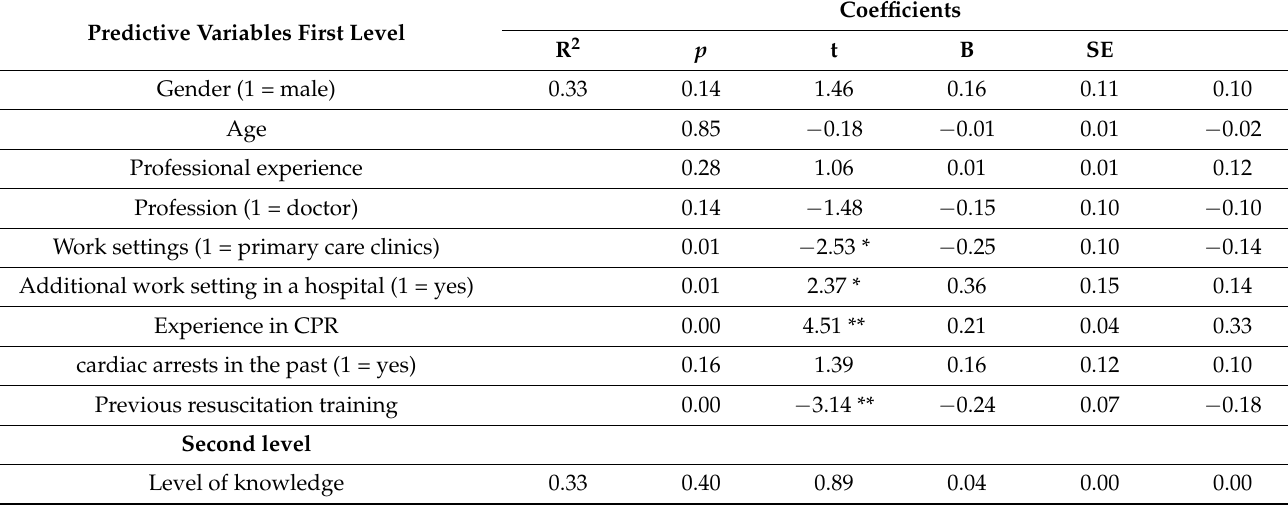
Table 4. Regression coefficients to predict the level of confidence in performing